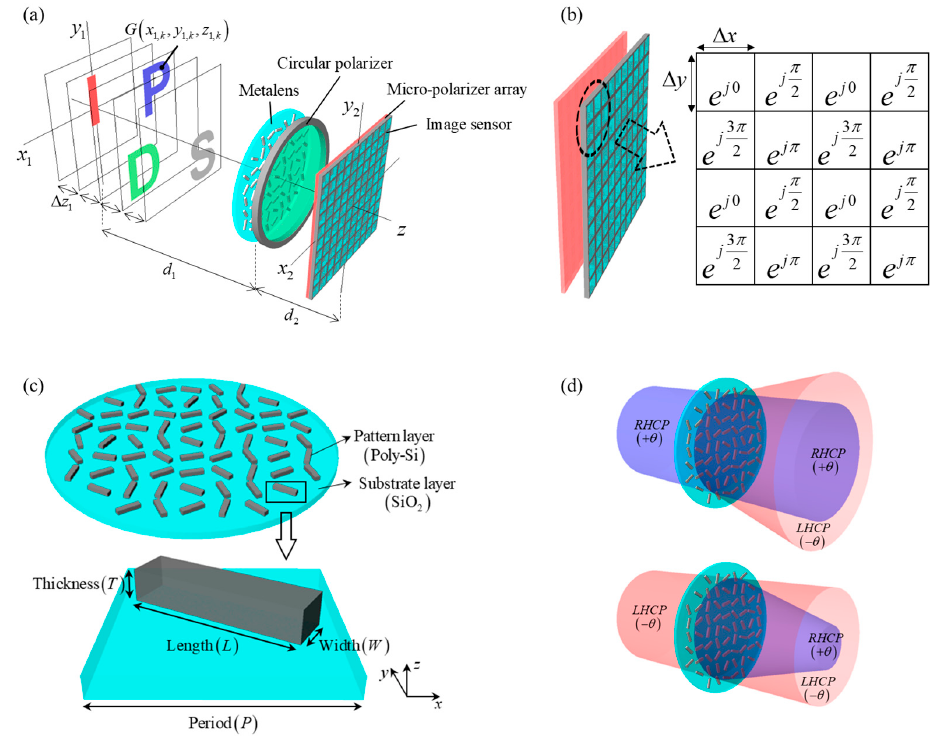
Figure 1. ( a ) The scheme of the self-interference incoherent digital holography (SIDH) system with metalens, ( b ) the image sensor with micro-polarizer array and the phase-shifted value δ of the corresponding matched subpixel, ( c ) the all-dielectric metalens and a unit pixel, and ( d ) the phase modulations of the metalens for the right-handed circular polarization (RHCP) and left-handed circular polarization (LHCP) incidence beams.